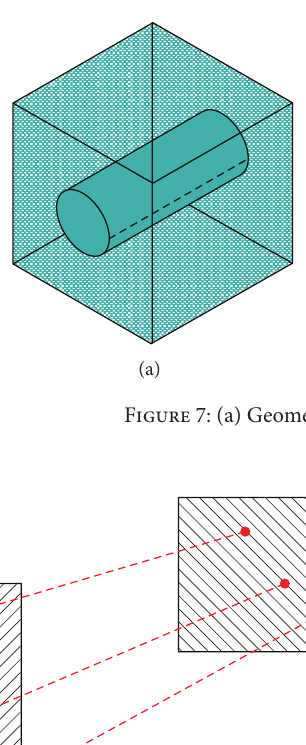
Figure 6: (a) Random distributed and (b) transversely distributed short fibre composite RVE generated by RSA and FE mesh in Kari et al. [26].